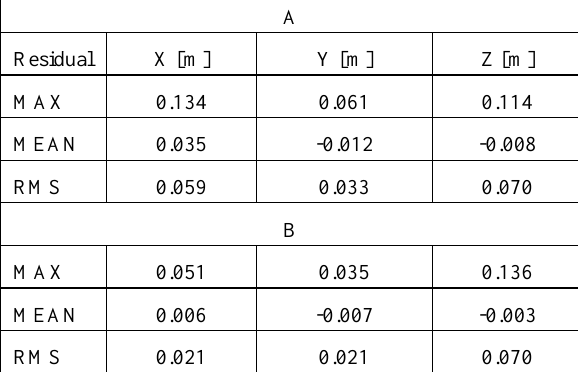
Table 5. Residuals at 9 check points, no GCPs used in the adjustment; A – position observations, B – position and